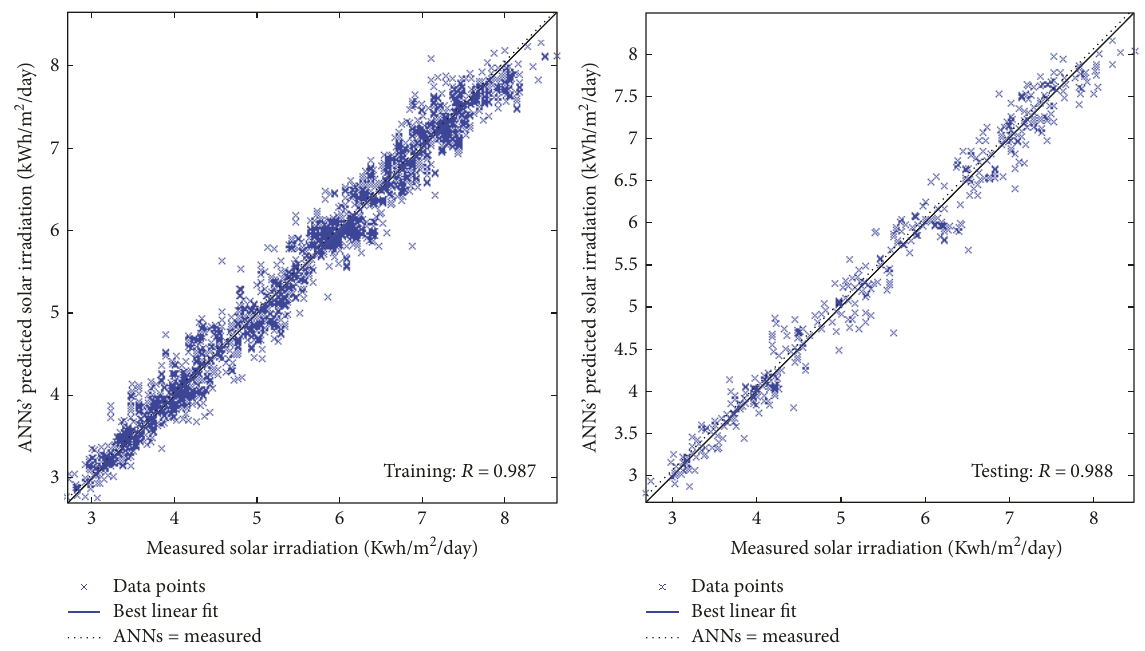
Figure 4: The scatter plot of ANN estimated solar irradiation measured data for training set and testing (mean absolute error), RMSE (root mean square error), rRMSE (relative root mean square error), and the correlation coe ffi cient ( R ) between estimated and measured values of